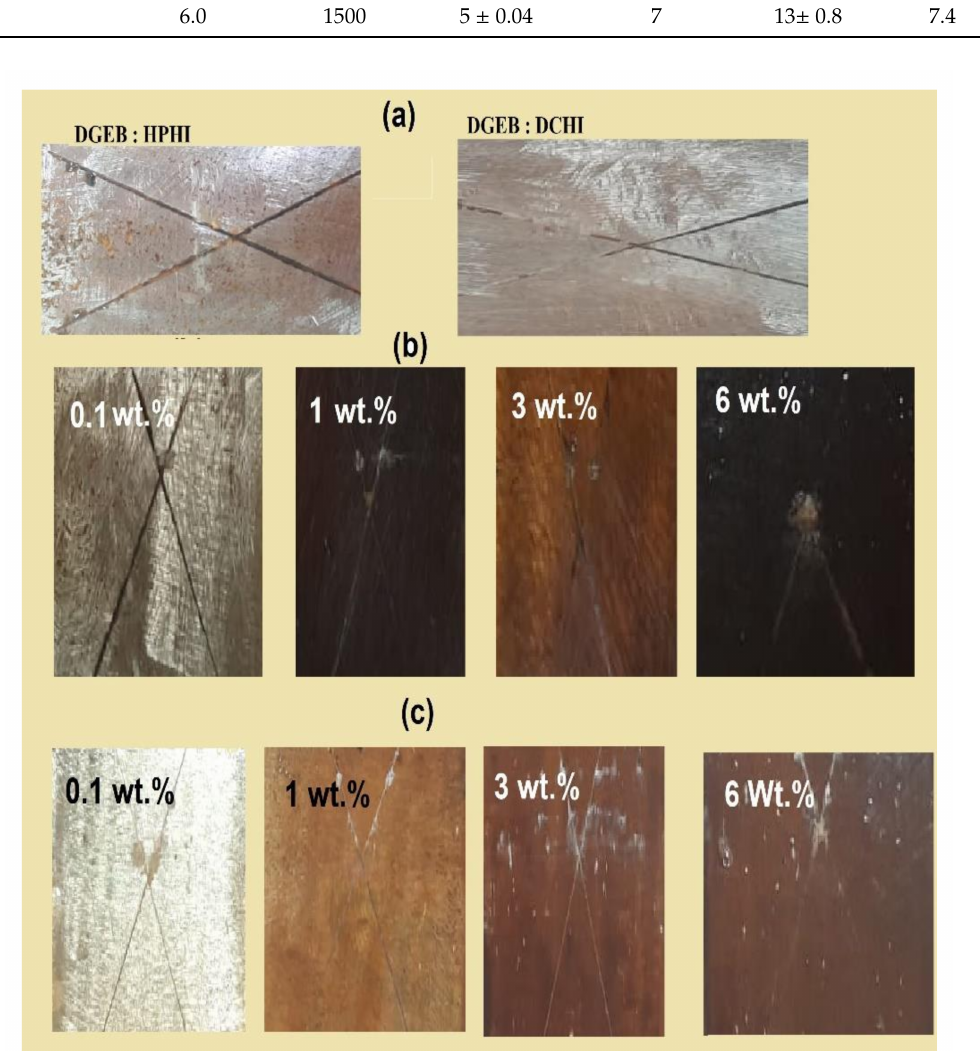
Figure 14. Salt spray photos of ( a ) DGEB / HPHI and DGEB / DCHI after 650 h, ( b ) DGEB / HPHI in the presence of HPHI-Fe 3 O 4 , and ( c ) DGEB / DCHI in the presence of DCHI-Fe 3 O 4 after exposure to di ff erent interval